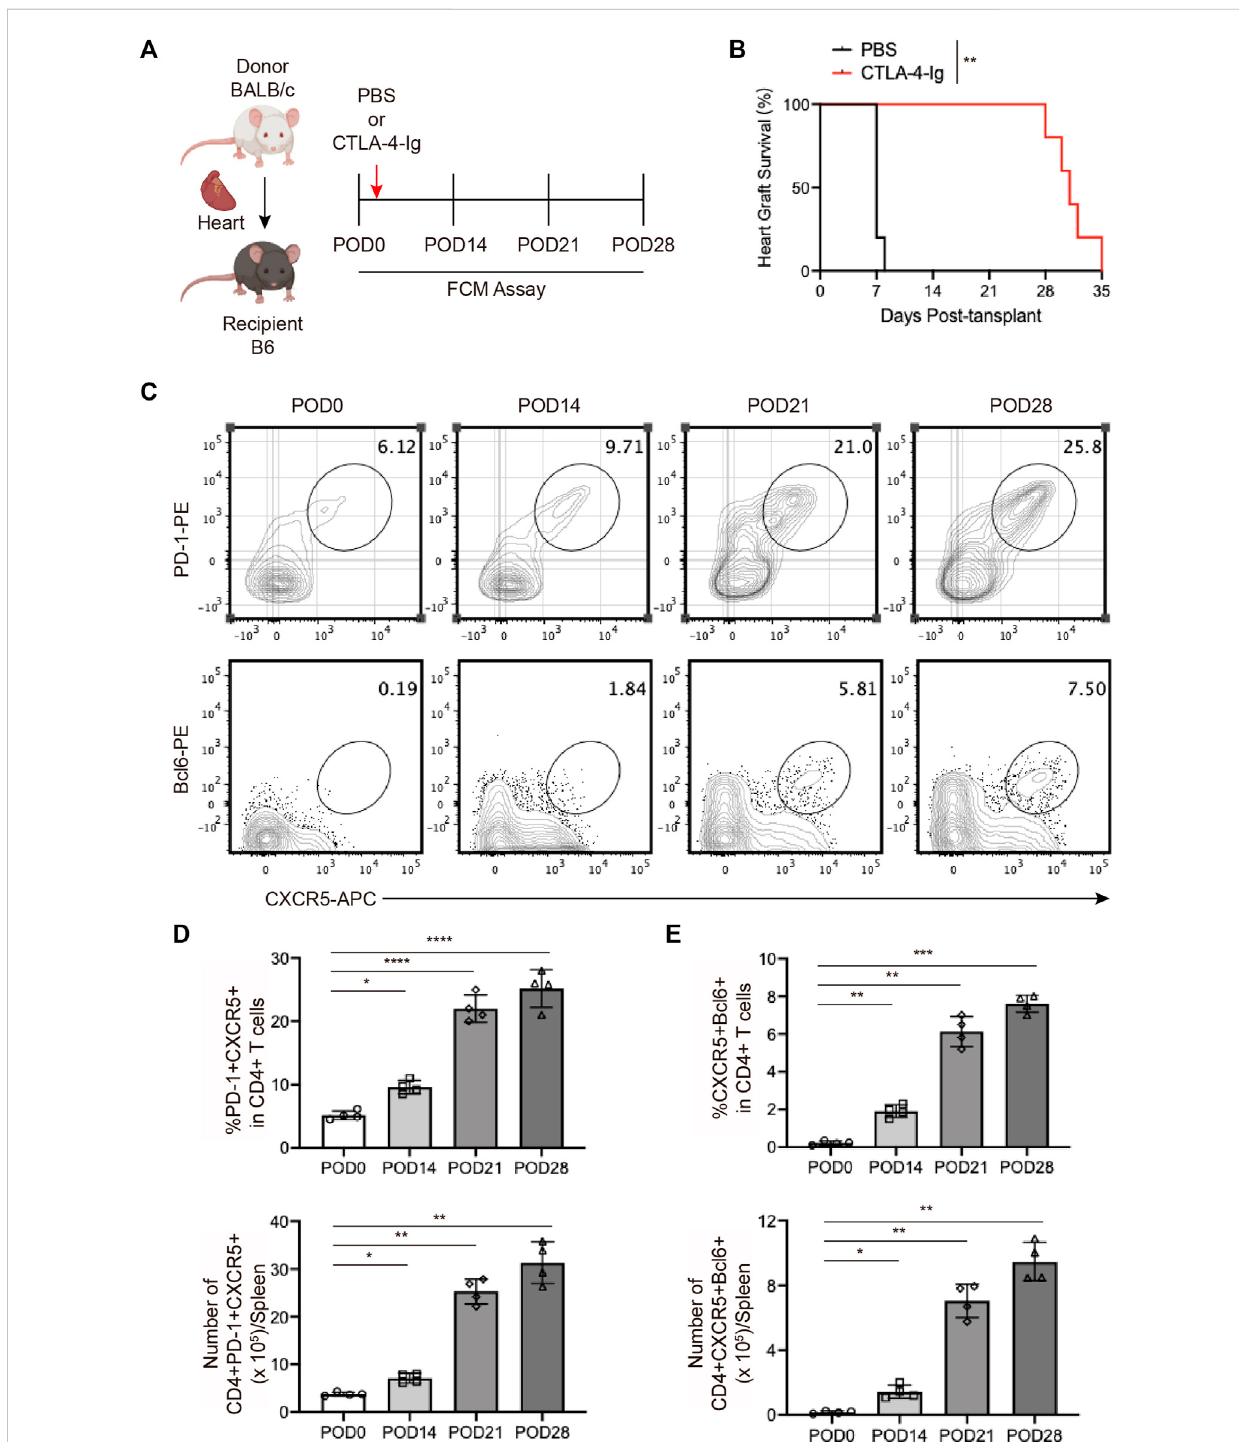
FIGURE 2 The expansion of T follicular helper cells during chronic cardiac transplant rejection in mice (A) . Illustration of the experimental design in (B – E) . The murine chronic cardiac transplant model was established. The mice were injected with 250 ug of CTLA-4-Ig or the equivalent amount of PBS intraperitoneally on the day after surgery, and their spleens were detected via FCM at 0, 7, 14, and 21 days post-transplantation. AuthorAnonymous, (B) . The survival status of the grafts was observed every day through palpation. The survival time is illustrated in the survival curves ( n = 6) (C) . FCM analysis oftheproportionsofPD1+CXCR5+ TfhandBCL6+CXCR5+Tfhcellsinthespleensofrecipientmiceat0,7,14,and 21 dayspost-transplantation (D) . The bar charts ( n = 4) show the ratios and numbers of PD1+CXCR5+ Tfh cells in the spleens at different time points, as described in 2a (E) . The bar charts ( n = 4) show the ratios and numbers of BCL6+CXCR5+ Tfh cells in the spleens at different time points, as described in 2a.Error bars represent SD. ns, not signi fi cant, * p < 0.05, ** p < 0.01, *** p < 0.001, **** p <